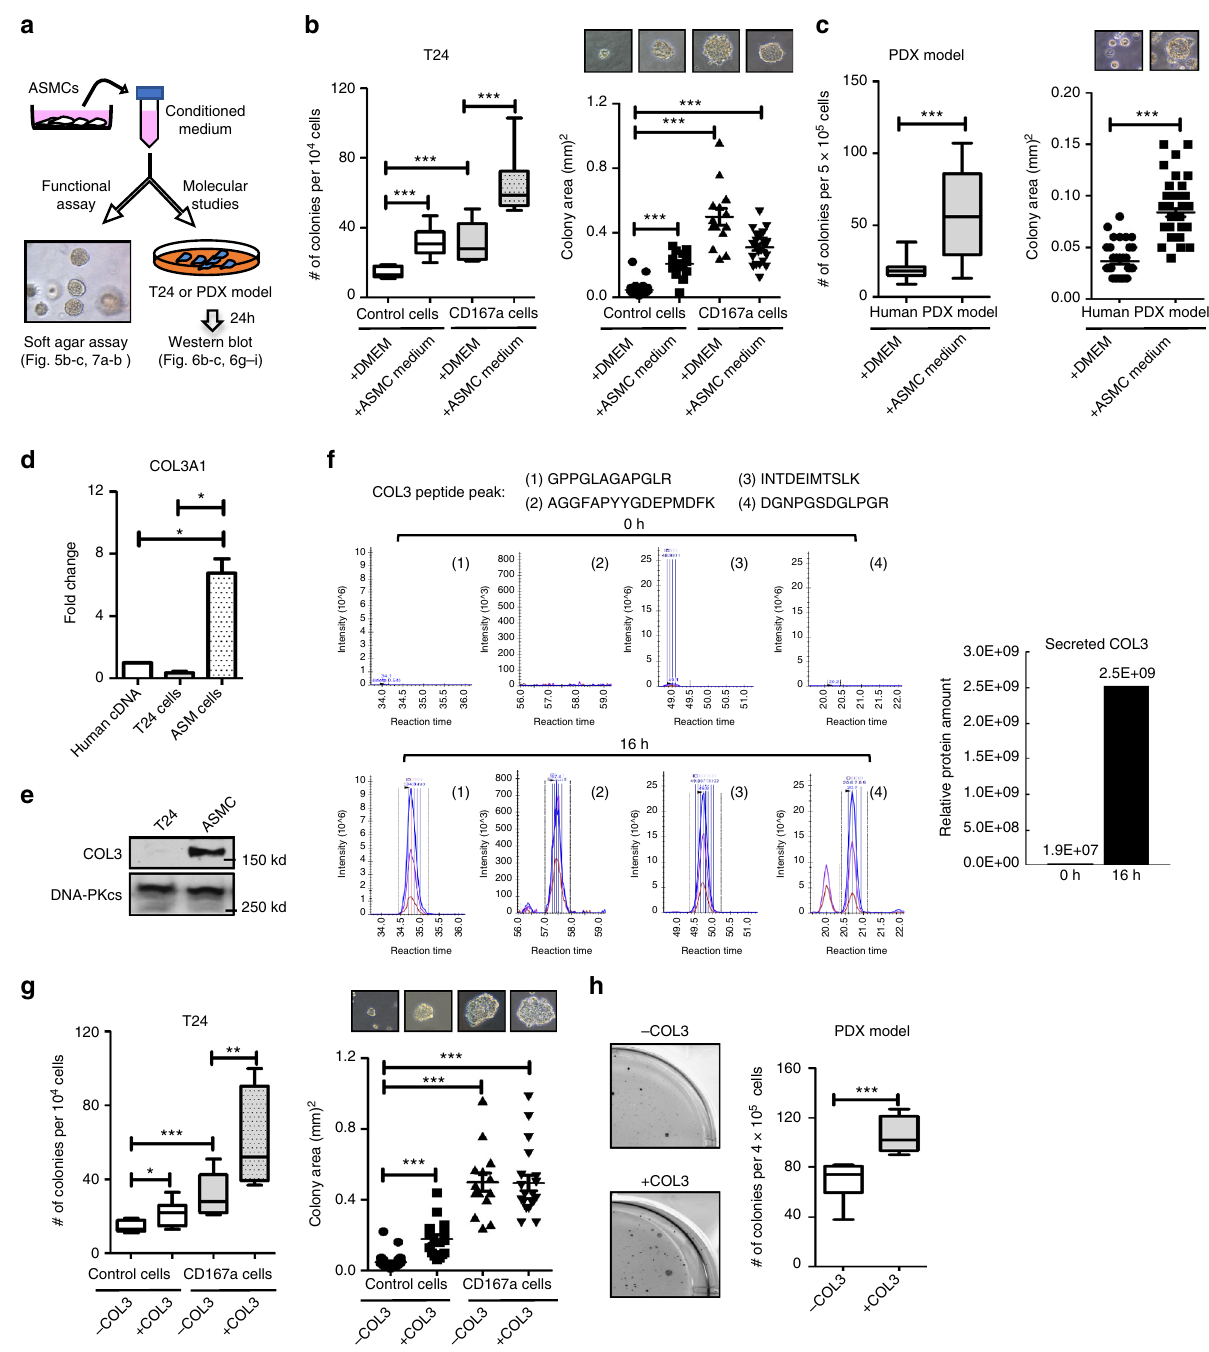
Fig. 5 Effects of airway smooth muscle cells and collagen III in colony formation. a Schematic illustrating the overall scheme of conditioned media collection from airway smooth muscle cells (ASMCs) for the evaluation of its impact on colony formation in vitro, and subsequent molecular analysis. b Quanti fi cation and size measurement of colonies formed from control and CD167a-overexpressing T24 cancer cells, and c a human metastatic PDX model in a classical soft-agar assay, in the presence or absence of ASMC conditioned media over a 14-day period. Representative phase-contrast images depict the relative colony size from respective conditions. d Quantitative real-time qPCR analysis of COL3A1 mRNA in cultured human ASMCs. Human cDNA mix and cultured T24 cells were harvested as controls. GAPDH was used as reference and the relative expression was normalized against human cDNA mix. e Western blot analysis of COL3 expression in human ASMCs and T24 cancer cells. DNA-PKcs was used as the loading control. f Targeted mass spectrometry analysis to evaluate protein peptides speci fi c toward COL3, that were secreted into the supernatant or conditioned media collected from cultured human ASMCs at 0 h and 16 h after incubation. The amount of COL3 was calculated based on MS1 signal area under curve using SKYLINE software based on top four strongly detected peptides. g Colony formation assay of control and CD167a-overexpressing T24 cancer cells upon COL3 treatment (50 μ g ml − 1 ). Number and size of colonies are shown on the left and right panel, respectively. h Colony formation assay of the human metastatic PDX model upon COL3 treatment (50 μ g ml − 1 ). Statistical analysis: a two-tailed, unpaired student ’ s t -test. Error bar: mean ± SEM. * p < 0.05, ** p < 0.01, *** p <